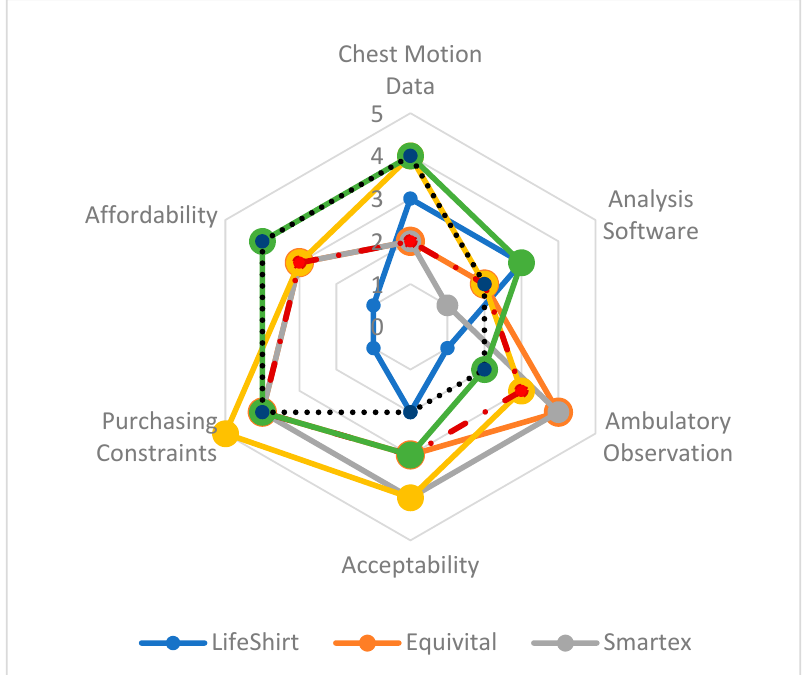
Figure 2. WRM assessment results using scoring rubric (Table 1).